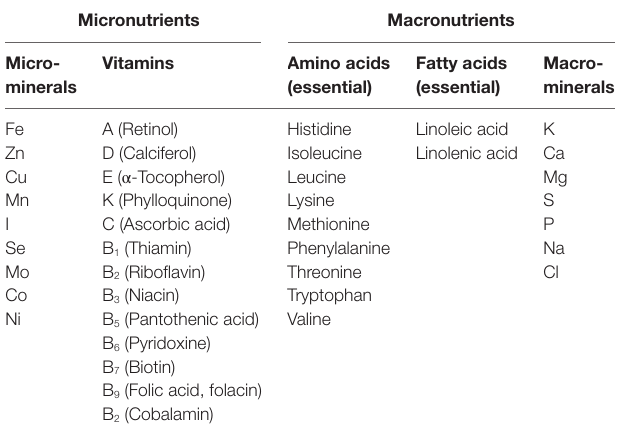
TABLe 1 | Essential micro- and macronutrients required for good human